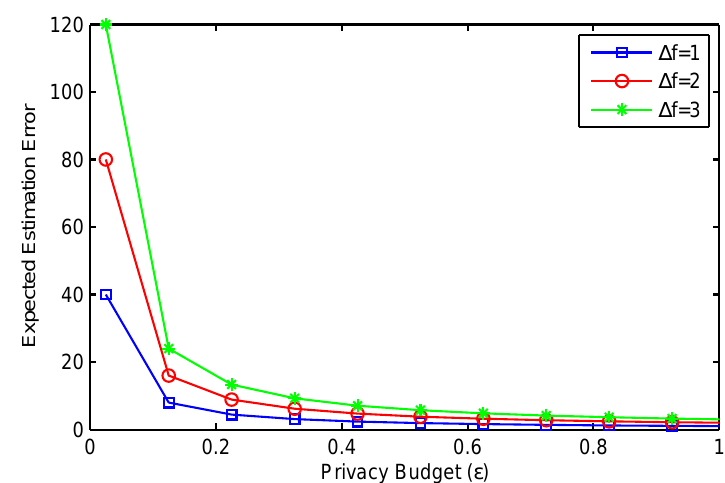
Figure 3. Expected estimation error of query results of Laplace mechanism.